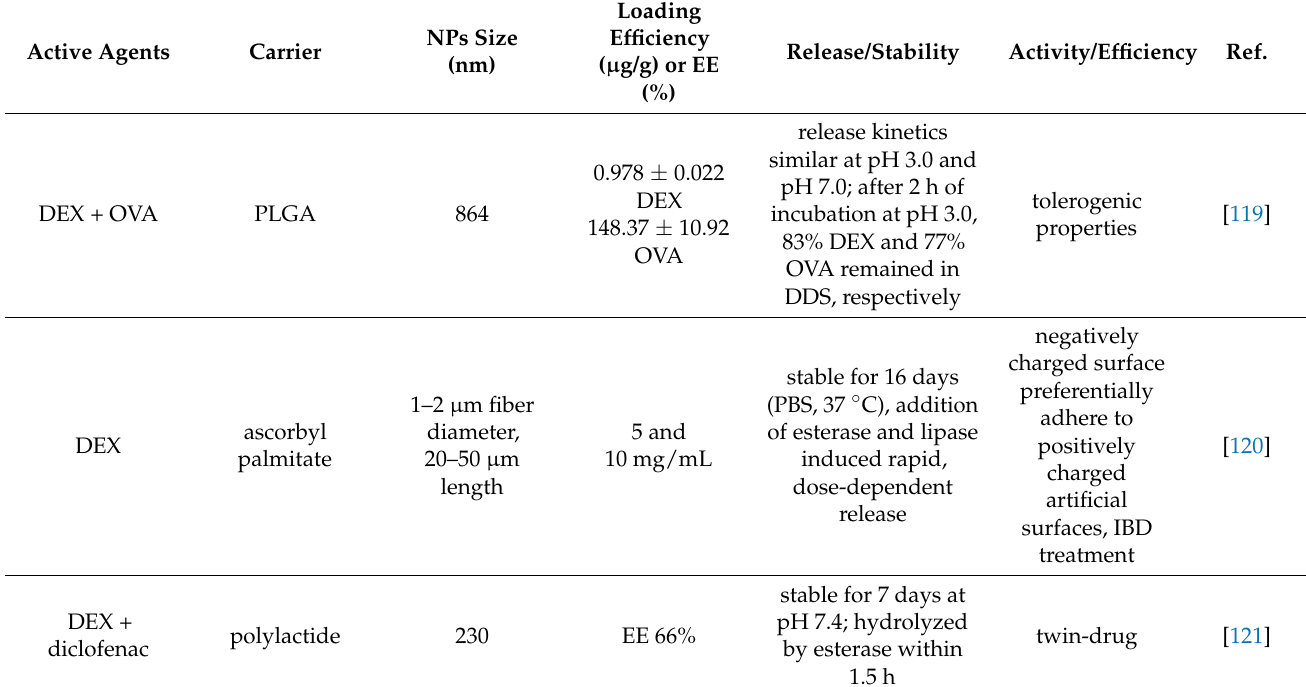
Table 1. Summary of selected drugs with anti-inflammatory effect and their nanoformulations.